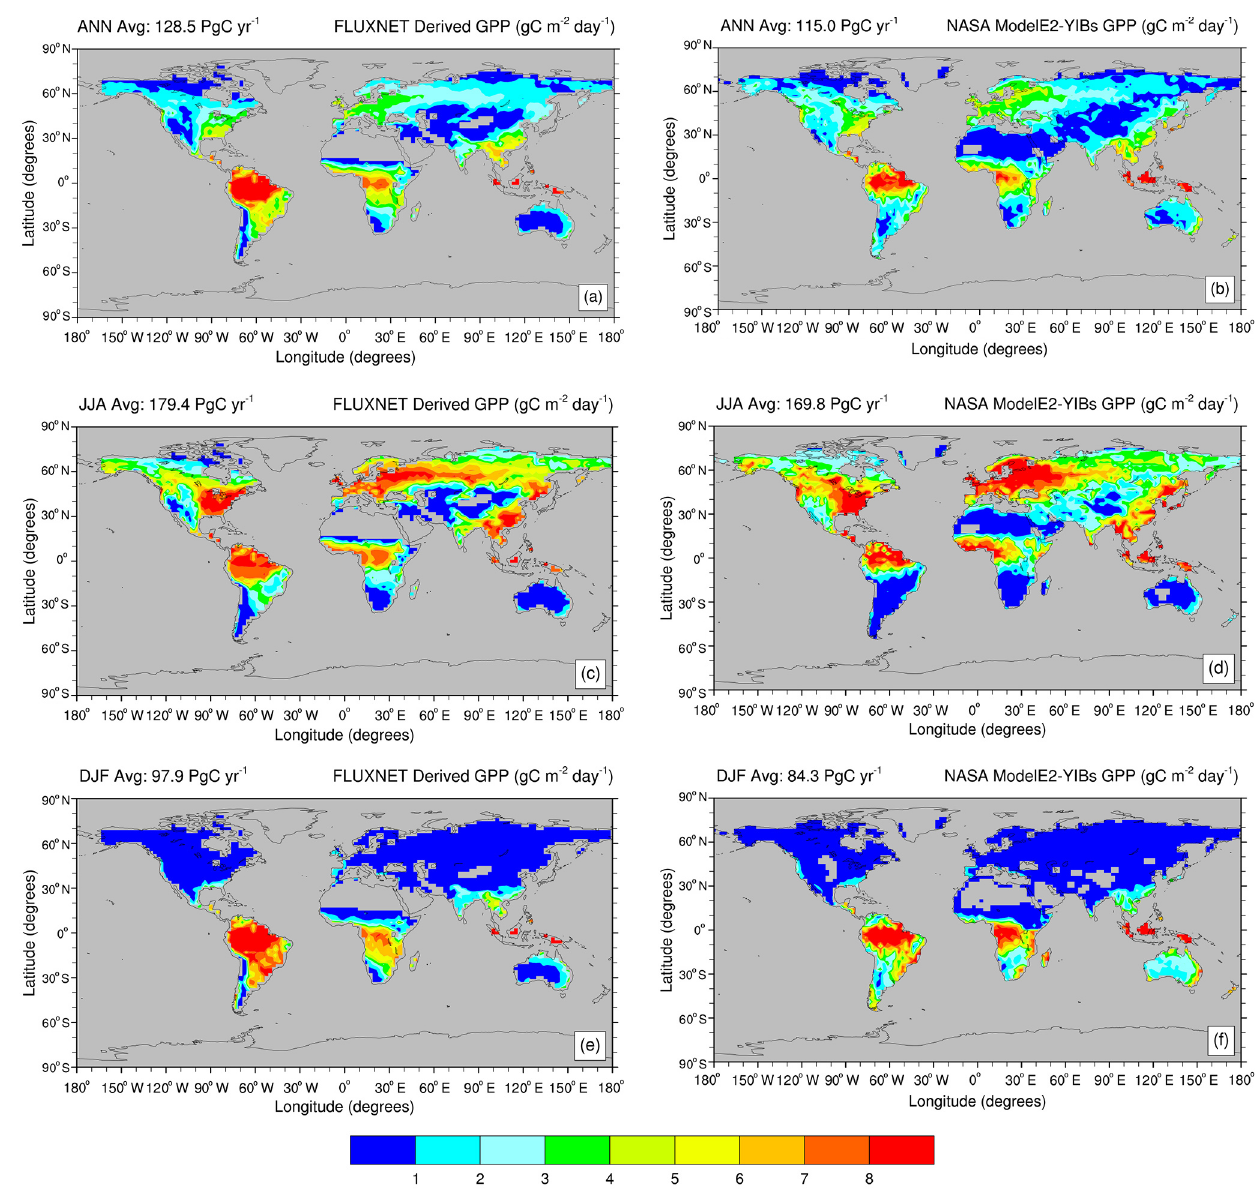
Figure 3. Annual and seasonal average gross primary productivity (GPP, in gm − 2 day − 1 ) as seen by (a, c, e) a global FLUXNET-derived GPP product (averaged over 2000–2011), and (b, d, f) NASA ModelE2-YIBS in the control present-day simulation ( ∼ 2000s). Global mean values are given in the upper left corner of each map. Only boreal summer (JJA) and winter (DJF) seasonal averages are shown.